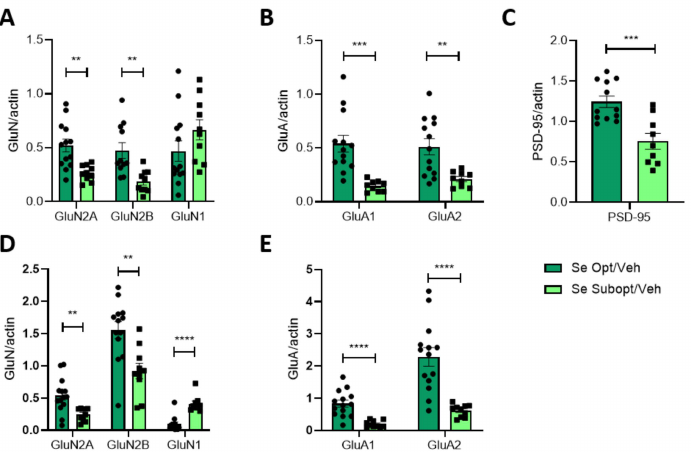
Figure 5. Effect of Se diet on the protein expression and post-synaptic trafficking of glutamatergic receptors and PSD-95 in juvenile rats. Quantification of NMDA and AMPA receptor subunits in the hippocampus of PND 23 rats homogenate ( A – C ) and TIF ( D , E ). Animals were fed with optimal or suboptimal Se diets. Data are shown as individual value plots and are represented as ratios of actin levels ( n ≥ 7). Unpaired t -test, ** p < 0.01, *** p < 0.001, **** p < 0.0001. Opt-Se: GluN2B n = 11, GluN1 n = 12 due to technical